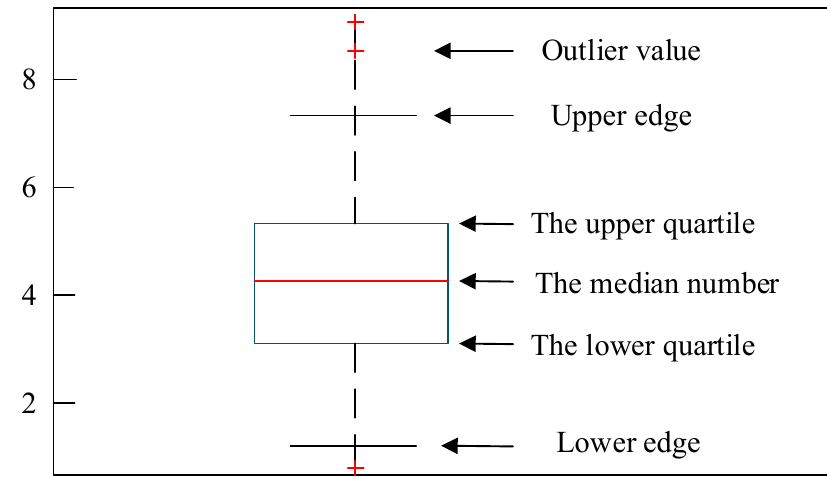
Figure 1. Box-type plot.